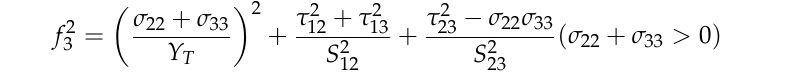
Table 5. Degradation coefficient under different failure modes [21]. Failure Mode